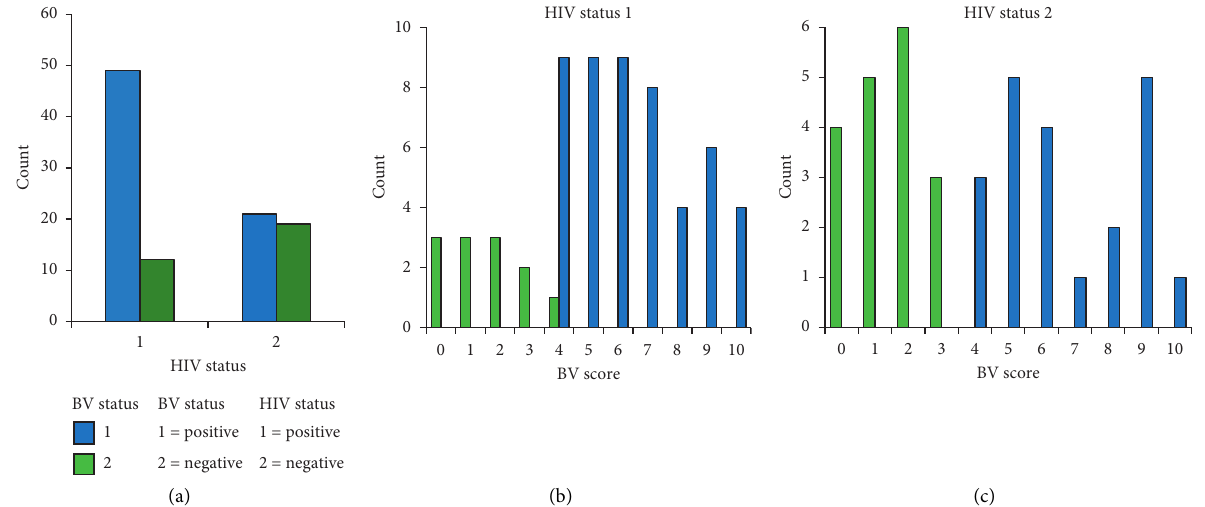
Figure 1: The association between (a) HIV status and BV status, (b) HIV (+) and BV (positive and negative), and (c) HIV ( − ) and BV (negative and positive).